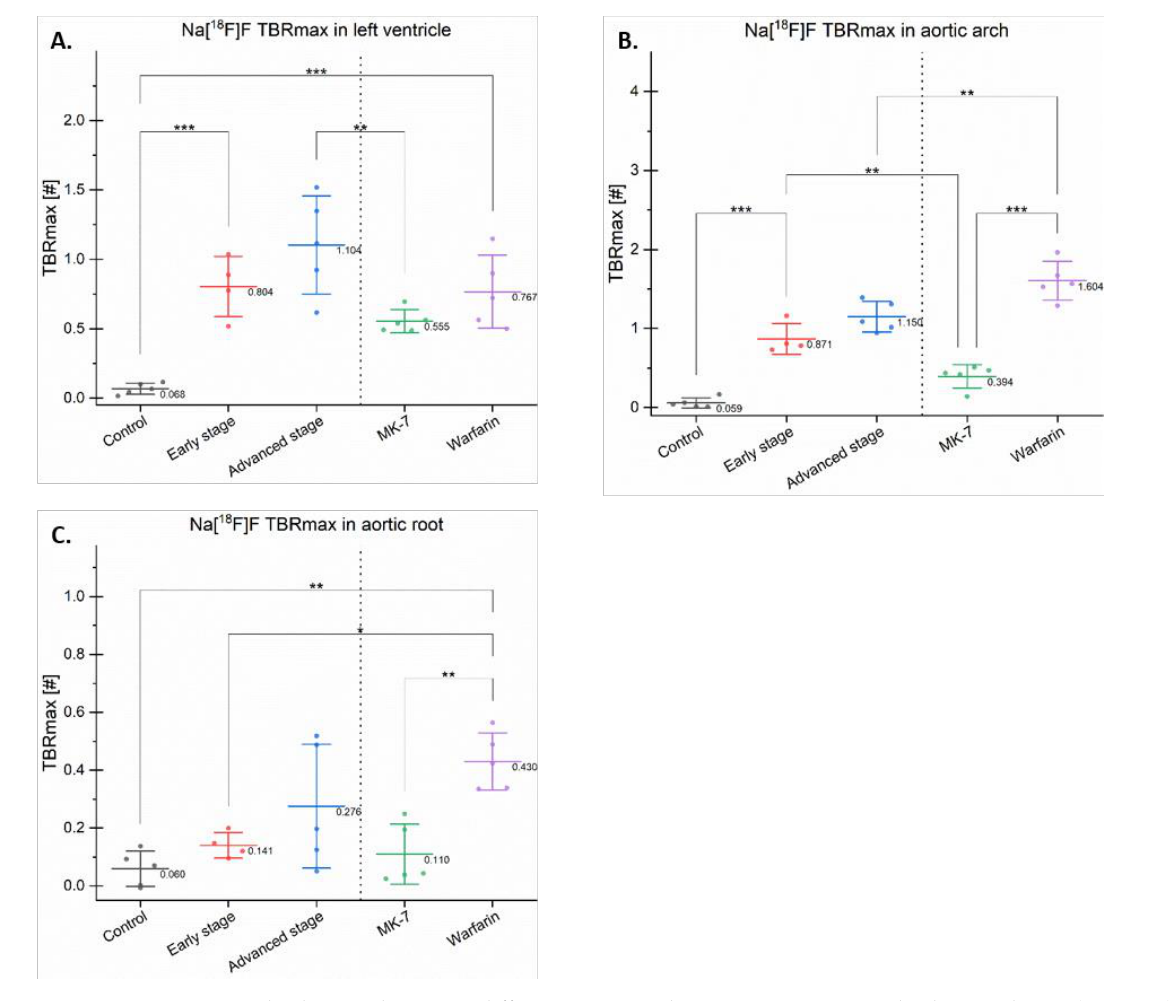
Figure 5. Maximum target-to-background ratios in different regions. The maximum target-to-background ratio (TBRmax) of Na[ 18 F]F is presented as dots with a line and a value indicating the mean and error bars for the standard deviation in the left ventricle ( A ), aortic arch ( B ), and aortic root ( C ); * p < 0.05, ** p < 0.01, *** p < 0.001.